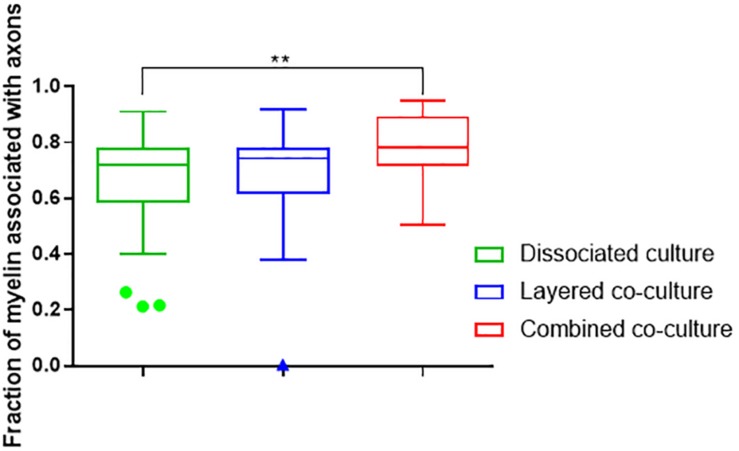
Fraction of PLP/DM20 associated with phosphorylated neurofilament. Data acquired at 35 days in co-culture (n = 3, ∗∗p < 0.01).